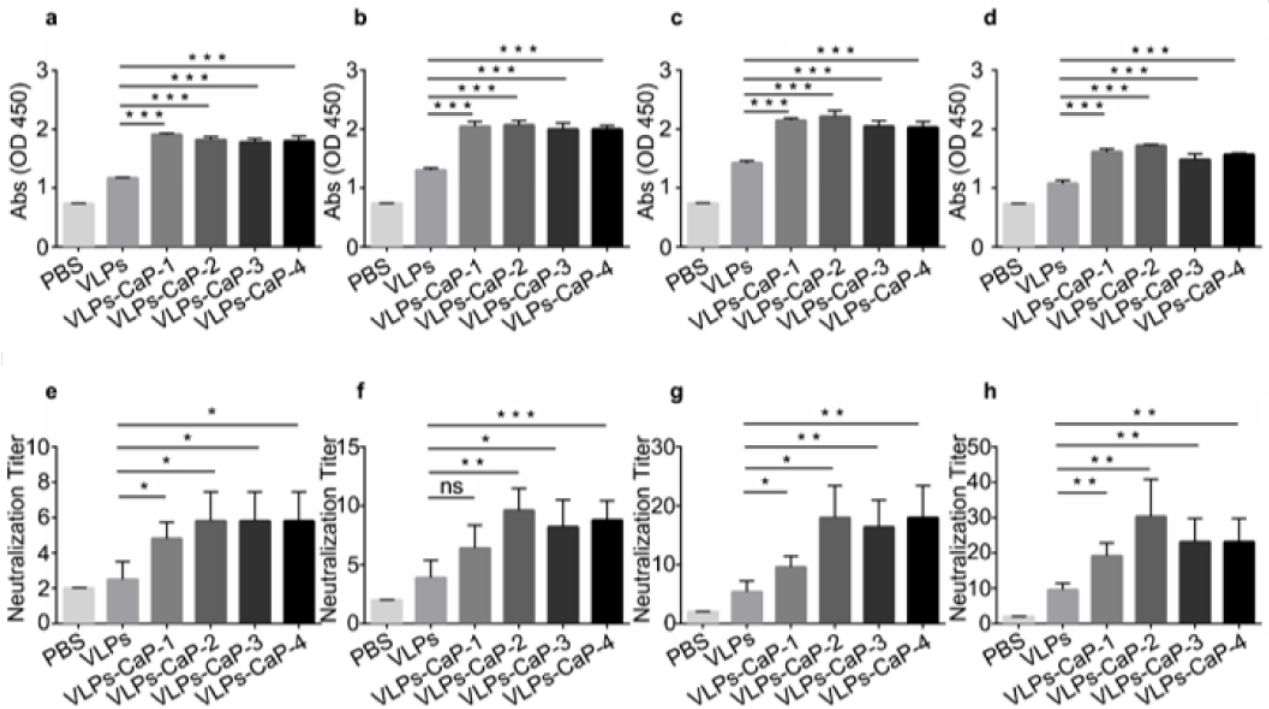
Figure 7. FMDV-specific immune responses and protection in guinea pigs. Groups of guinea pigs immunized with PBS, VLPs (37 ◦ C for 2 days), CaP-VLPs-1 (37 ◦ C for 4 days), CaP-VLPs-2 (37 ◦ C for 4 days), CaP-VLPs-3 (37 ◦ C for 4 days), and CaP-VLPs-4 (37 ◦ C for 4 days). Blood samples were collected from the hearts of the guinea pigs on post-immunization days 7 ( a ), 14 ( b ), 21 ( c ) and 28 ( d ) to detect virus-specific Abs. The titers of the neutralizing Abs Were also measured on post-immunization days 7 ( e ), 14 ( f ), 21 ( g ) and 28 ( h ). Multiple comparisons were performed using one-way ANOVA, followed by Bonferroni ´ s post-test, and p values < 0.05 were considered significant. *, p < 0.05; **, p < 0.01; ***, p <